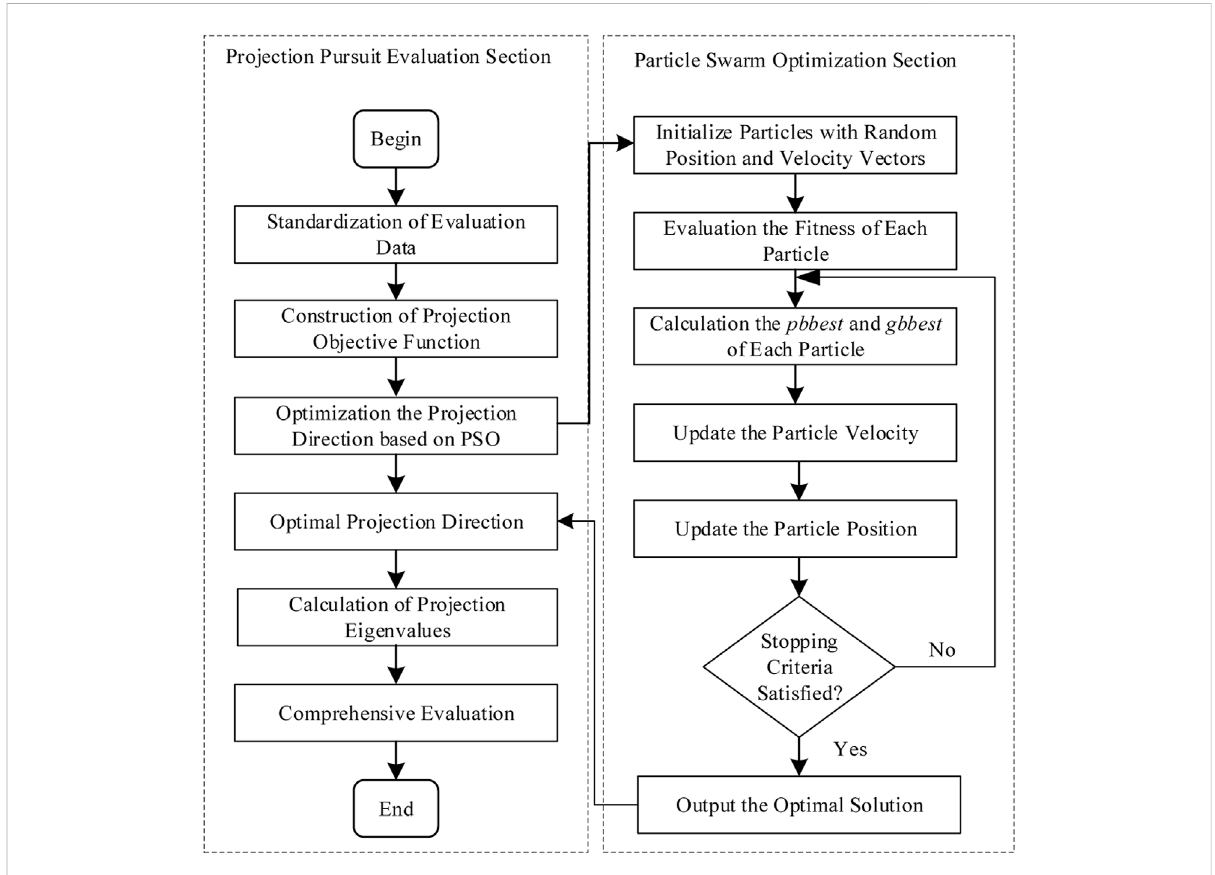
FIGURE 2 The calculation process of the BP-PSO